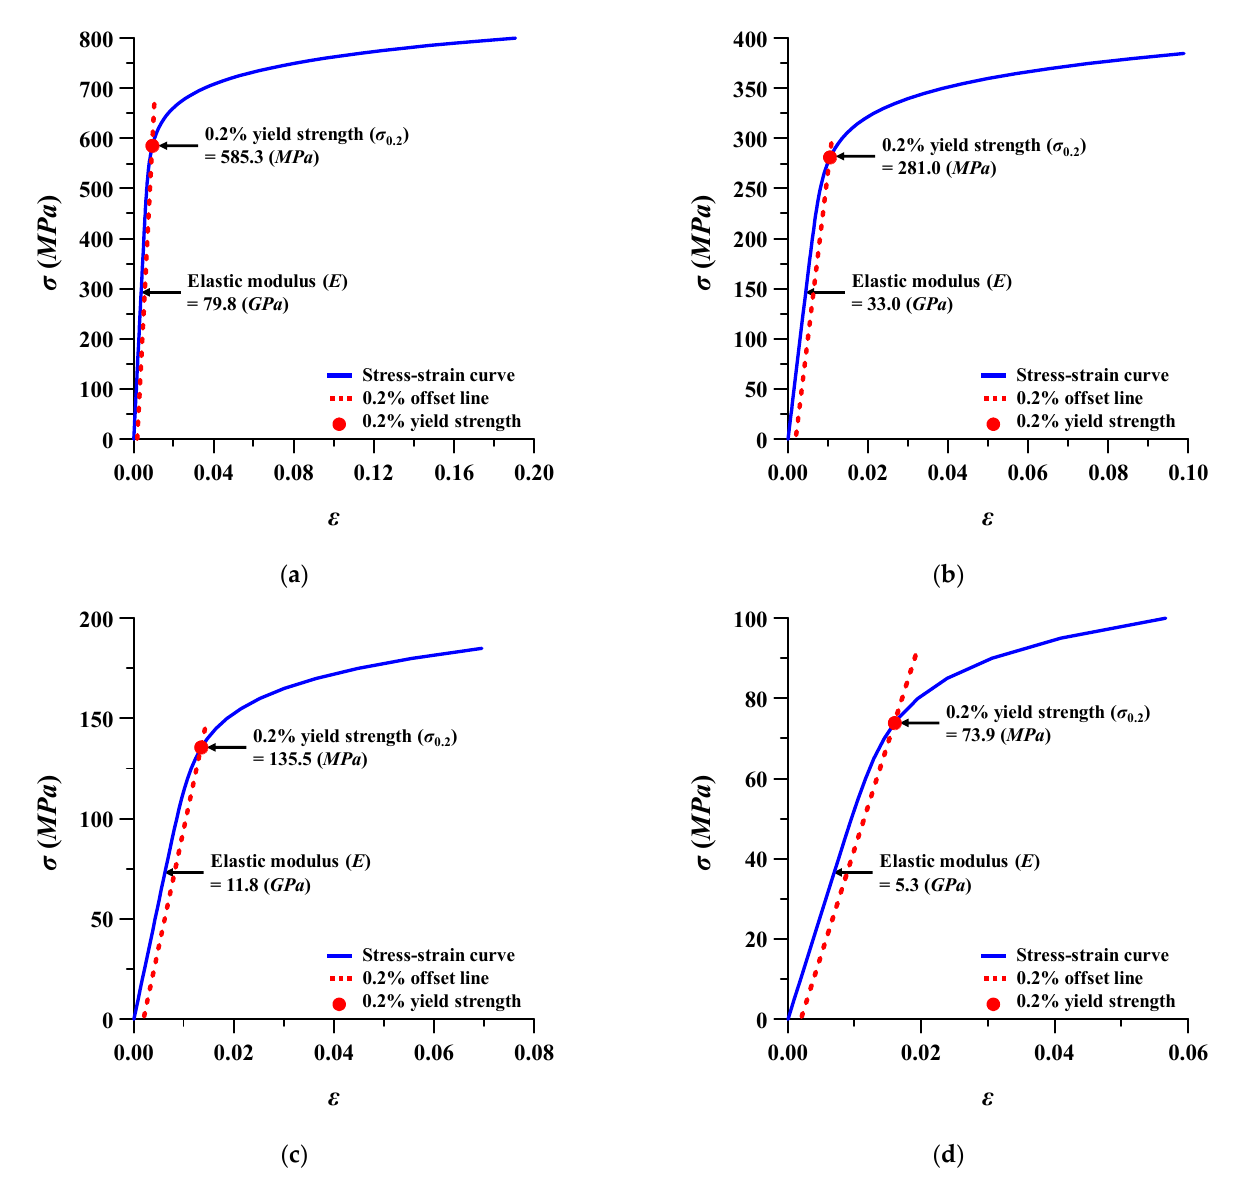
Figure 5. Stress ( σ )–strain ( ε ) behavior of Ti–6Al–4V at different porosities: ( a ) porosity 15%; ( b ) porosity 40%; ( c ) porosity 60%; ( d ) porosity 75%. Table 3. Scenarios for spinal motion simulation using spinal implants at different porosities ( p ):